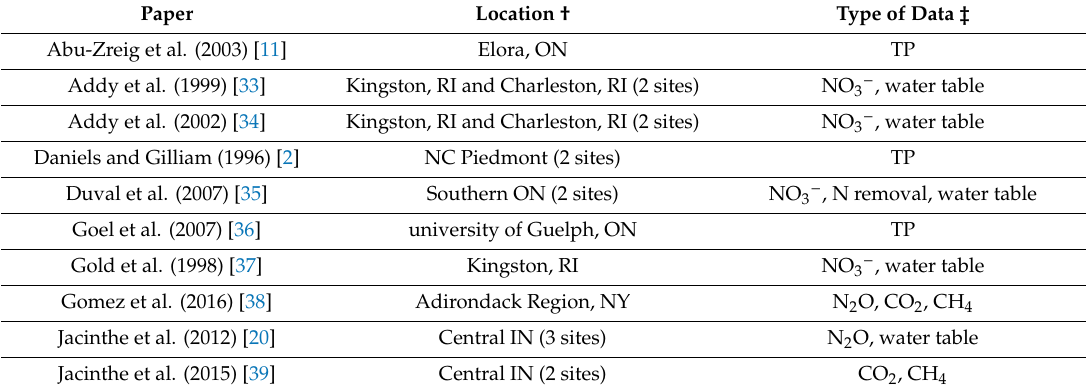
Table 1. Summary of studies used to obtain data for the development of individual models for each riparian function included in the riparian zone (RZ)-TRADEOFF water and air quality model. One site per study used unless indicated